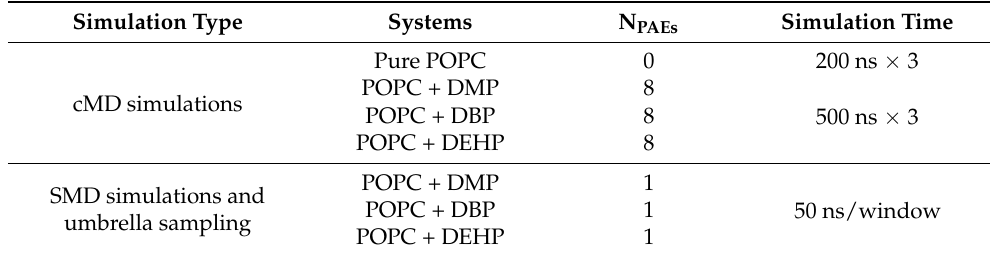
Table 1. System information for conventional and steered MD simulations and umbrella